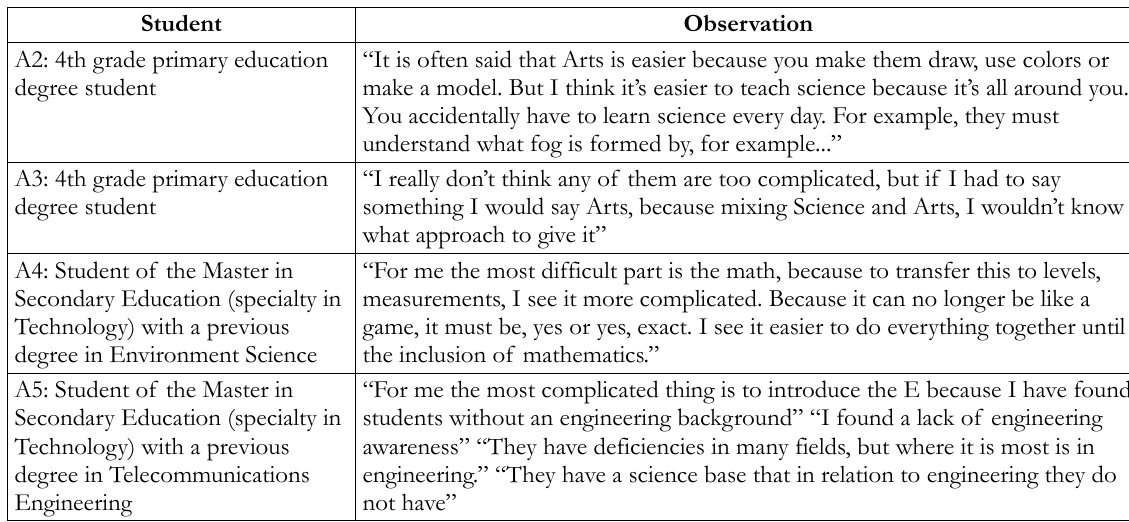
Table 4. Answers related to the category “Difficulty for the inclusion of STEAM disciplines”